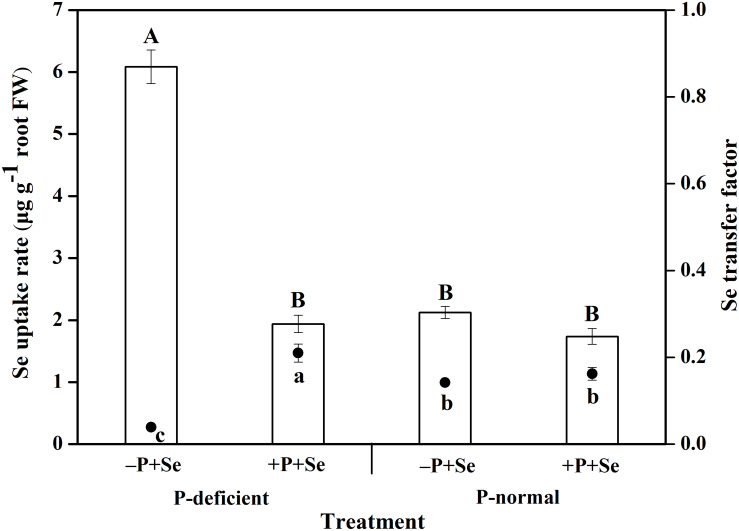
The uptake and translocation of Se in rice seedlings under different treatments. The histogram and scatter diagram depict the Se uptake rate and transfer factor in rice, respectively. Data are presented as means ± SEs (n = 3). The different capital and lowercase letters indicate statistically significant differences in Se uptake and translocation, respectively, among the treatments at P < 0.05 according to Duncan’s test.